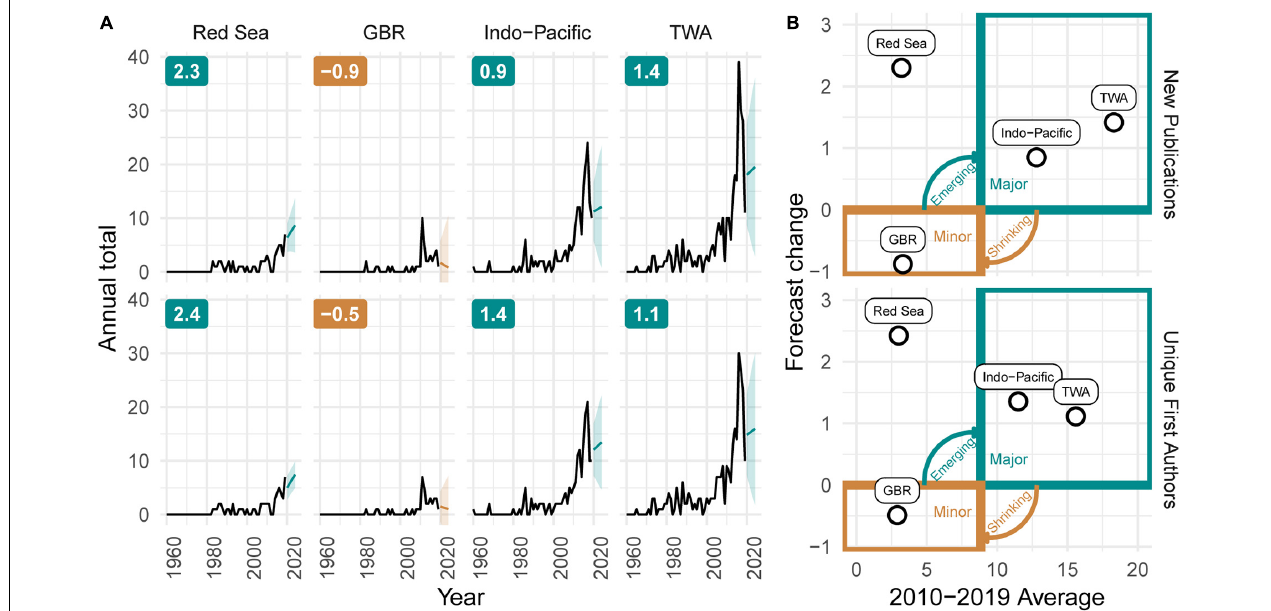
FIGURE 2 | Number of new publications (top panels) and unique first authors (bottom panels) each year, for the four main regions of mesophotic studies. (A) Future projections from Holt–Winters forecasting with 95% prediction interval presented in green (positive) and orange (negative) for 5 years from 2020. Numbers in the top left-corner box of each panel represent the forecast change by 2024. (B) Bi-plots characterize regions of mesophotic research as either minor, emerging, major, or shrinking, based on average outputs and forecast change. Publication and authorship data were collected from Mesophotic.org database (Bongaerts et al., 2019).